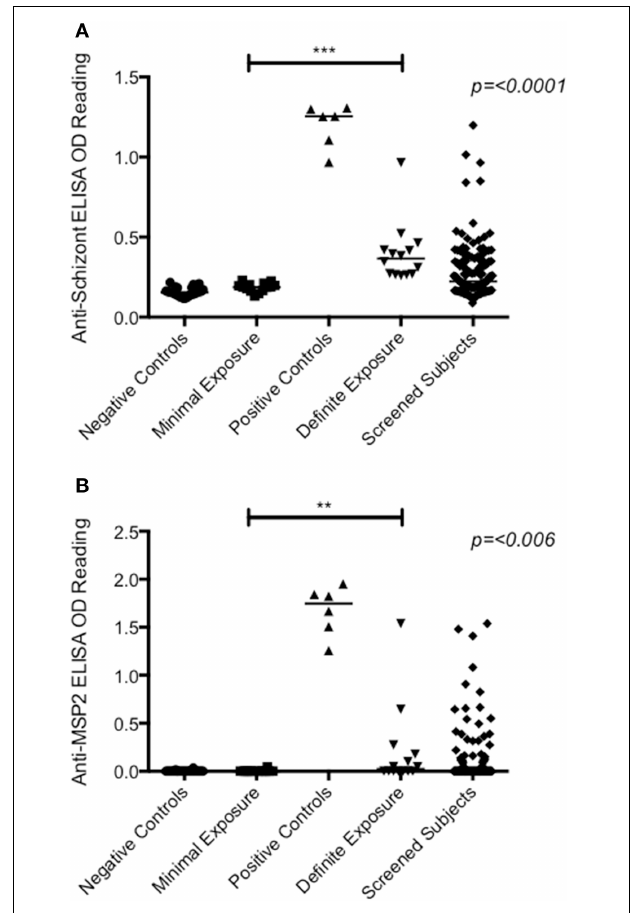
FIGURE 2 | Antibody ELISA absolute OD readings measured at screening. (A) Anti-schizont. (B) Anti-MSP2. Serum diluted 1:1000. Negative controls = OD readings from UK malaria naïve adults ( n = 30). Positive controls = OD readings from hyperimmune Kenyan adults living in malaria endemic regions ( n = 6). Minimal exposure = subjects enrolled in groups 1, 3, and 5 ( n = 14). Definite exposure = subjects enrolled in groups 2, 4, and 6 ( n = 14). Screened subjects = all volunteers that had blood drawn at screening ( n = 145). A significant difference was seen between minimally and definitely exposed volunteers for both antigens (Anti-schizont = p ≤ 0 . 0001; Anti-MSP2 = p = 0 . 006; Mann–Whitney test ). Median values represented by lines through each